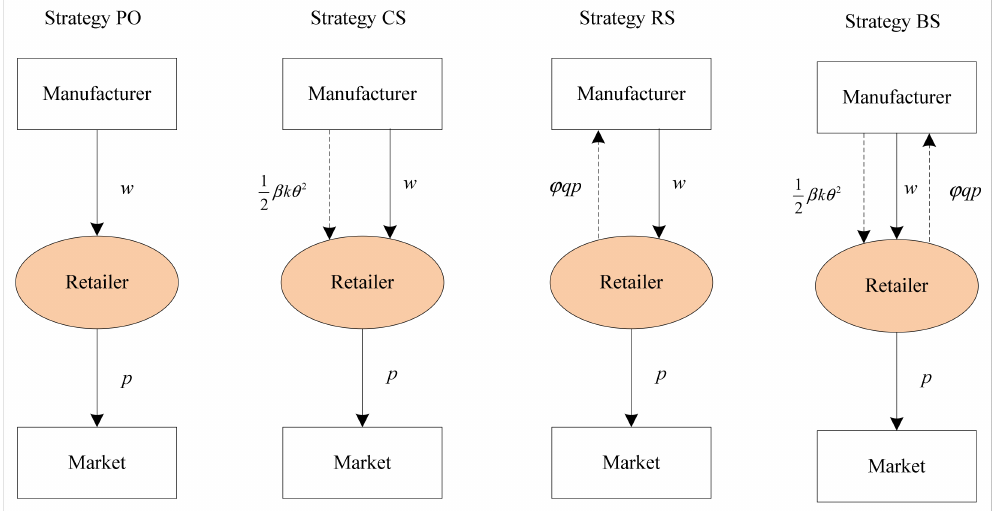
Figure 1. The retailer’s four incentive strategies. (1) Price-only strategy (Strategy PO): This strategy corresponds to the scenario where β = 0 and ϕ = 0. In this strategy, the retailer shares neither the investment